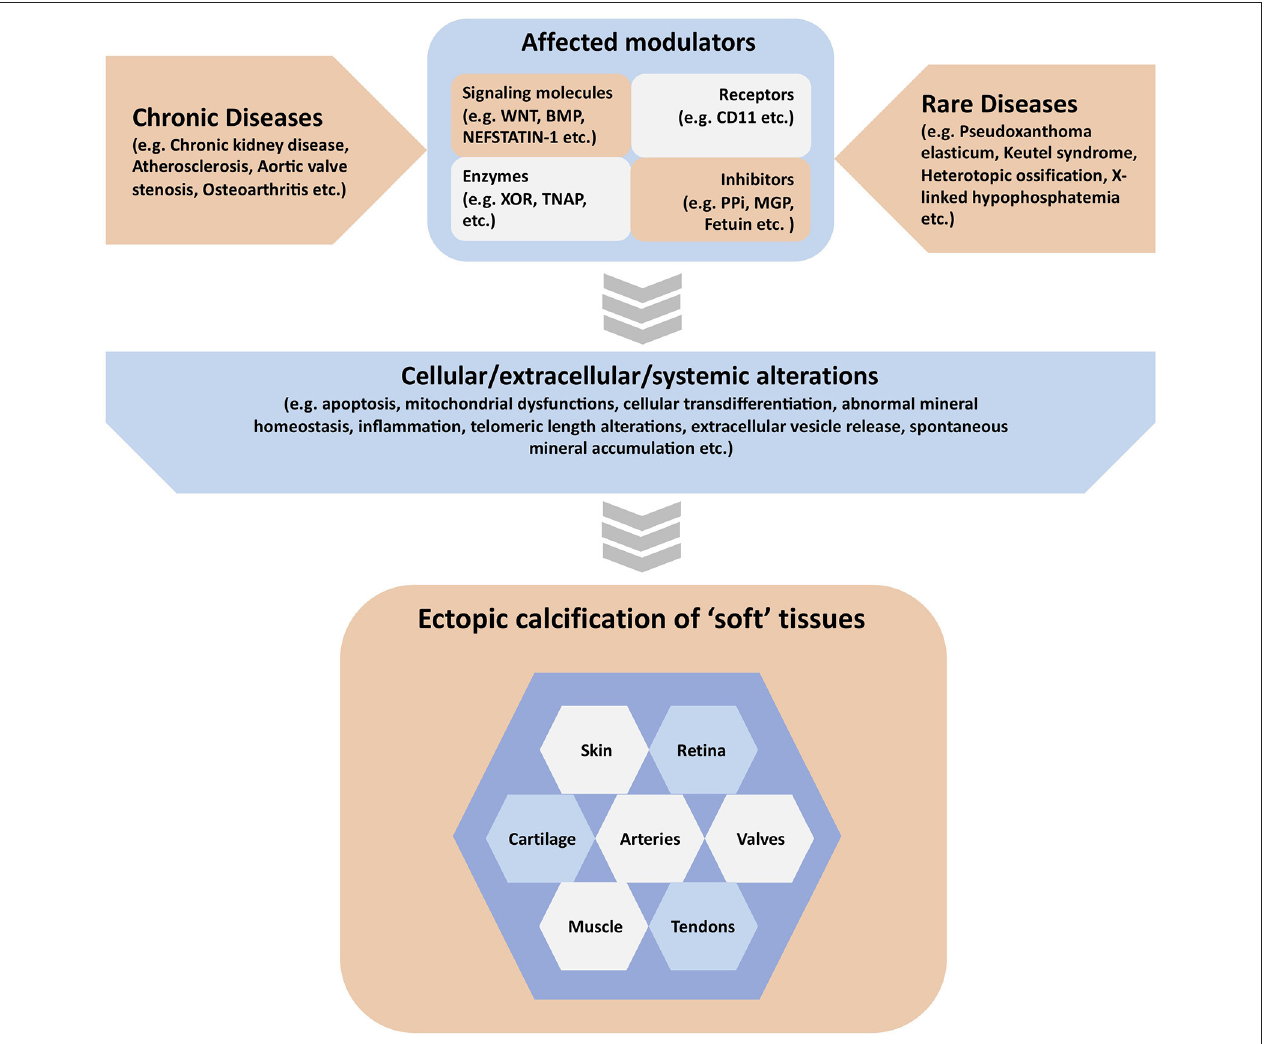
FIGURE 1 | Graphical summary of the contents covered in the manuscripts published in the special issue. Ectopic calcification in various “soft” tissues can be associated with both chronic and rare diseases. These diseases may affect one or more modulators of “soft” tissue calcification, which include but are not limited to signaling molecules, receptors, enzymes, and other proteins or inorganic molecules acting as mineralization inhibitors. These activating or inhibiting modulators may in turn alter a variety of cellular, extracellular and systemic parameters in the extracellular matrix causing the initiation and progression of ectopic calcification in various “soft”